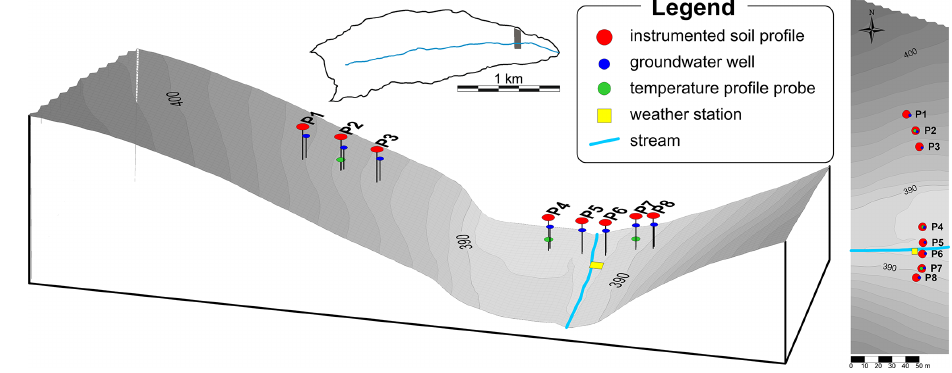
Figure 1. Spatial map in 3D and aerial view of the Schäfertal Hillslope site and location of the monitoring